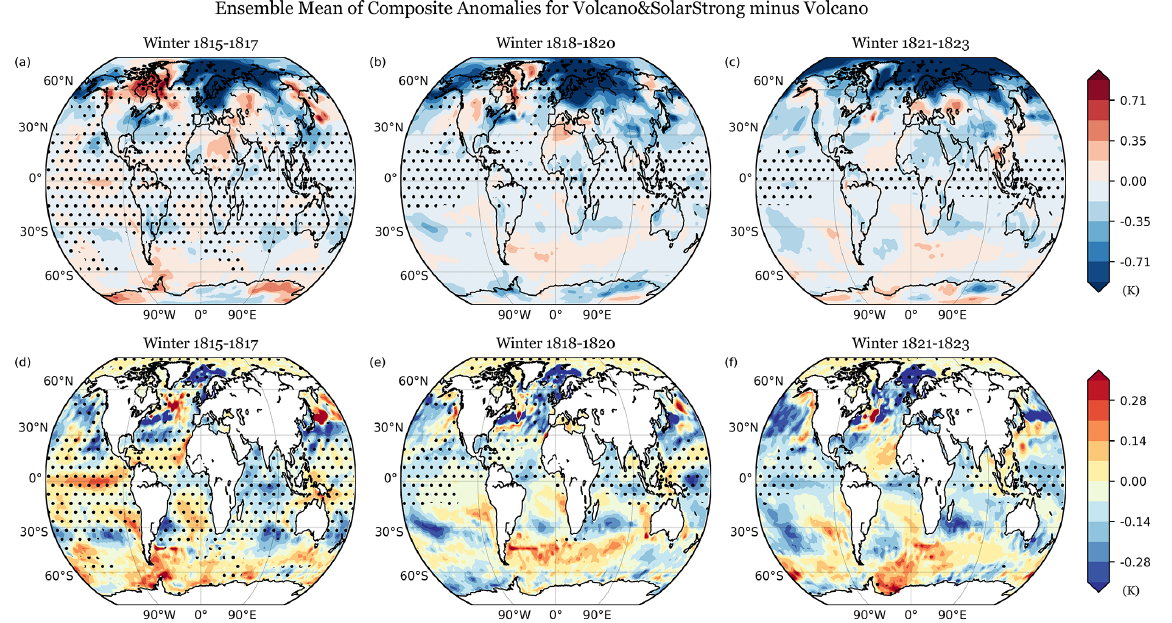
Figure 8. (a) Composite of ensemble mean winter SAT (K) over 1815–1817 for the Volcano&SolarStrong experiment minus the Volcano experiment. And the block dots show the grid points with significant difference (5% level) between the Volcano&SolarStrong and Volcano experiment with t test from 20 ensembles. (b) and (c) are for 1818–1820 and 1821–1823, respectively. (d) – (f) are for the SST (K). The color scale is the same as in Fig.